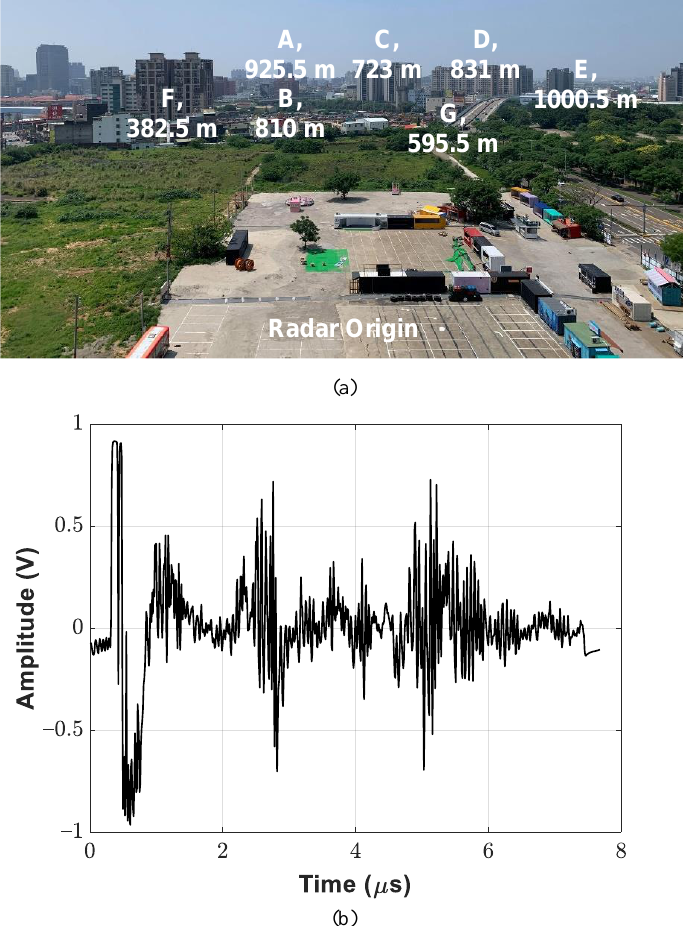
Figure 27. ( a ) Snapshot of target buildings. ( b ) Downconverted received waveform with pulse repetition period of 7.68 µ